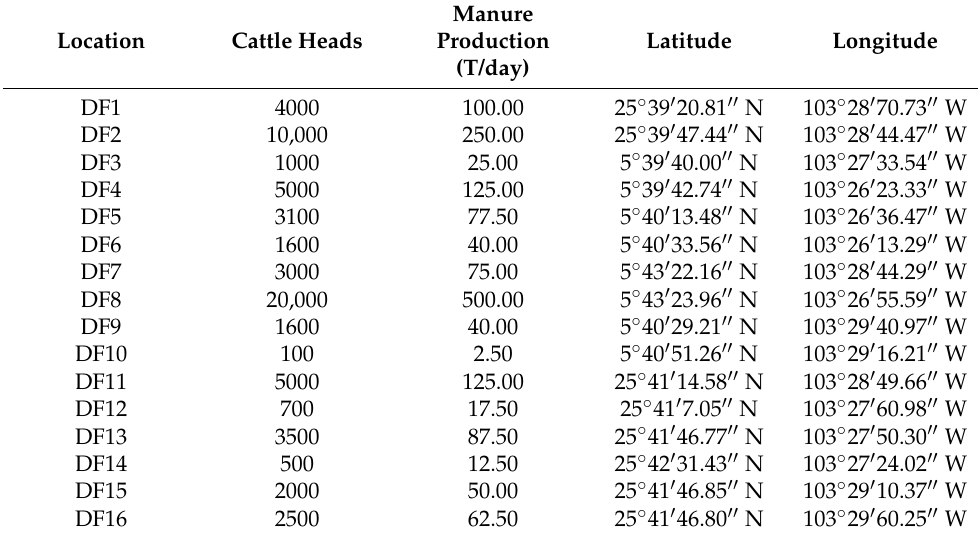
Table 5. Geographical locations of the livestock producers, cattle heads, and manure production.